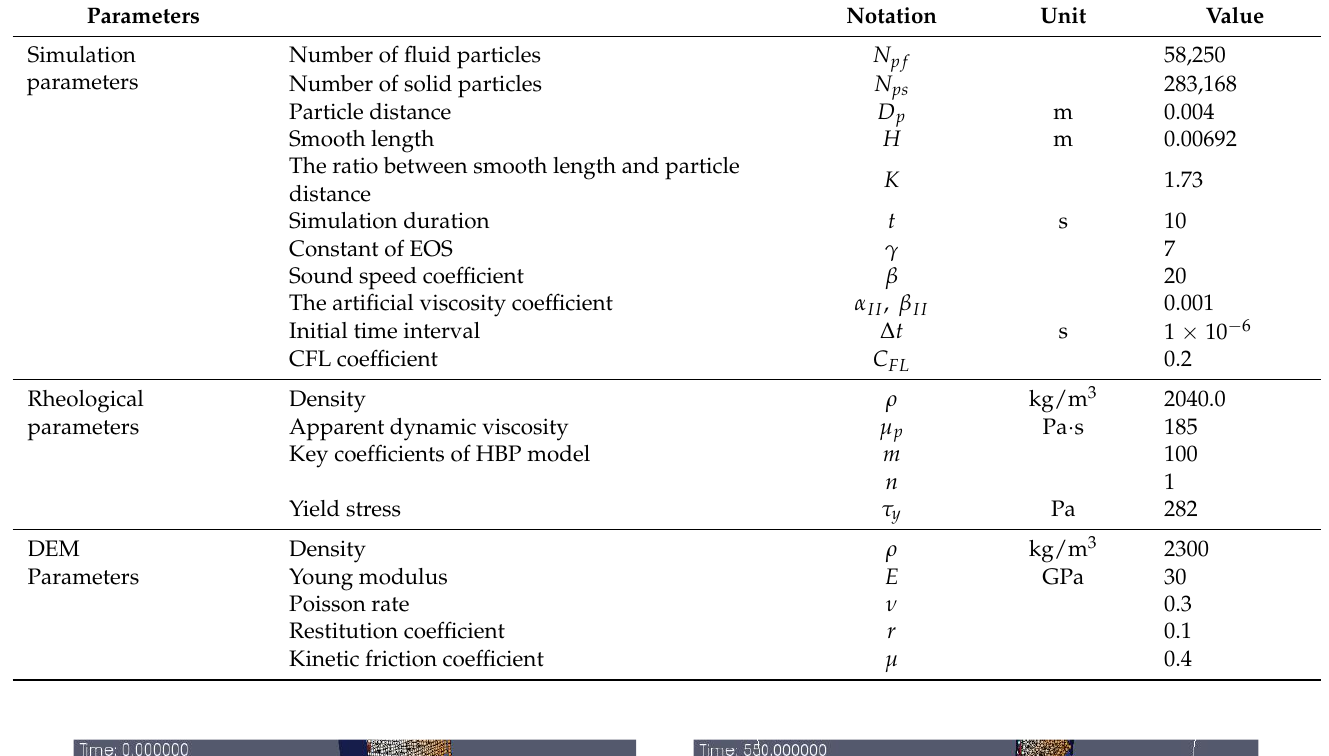
Table 4. Simulation parameters of SPH-DEM.